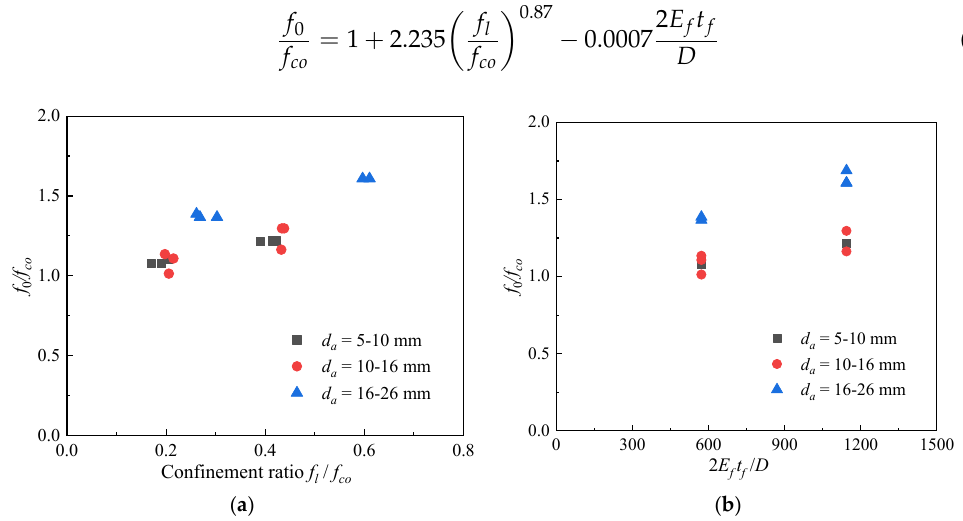
Figure 13. The relationship between the f 0 / f co and f l / f co and confinement stiffness (2 E f t f /D ). ( a ) Rela- tionship between the f 0 / f co and f l / f co . ( b ) Relationship between the f 0 / f co and 2 E f t f /D .